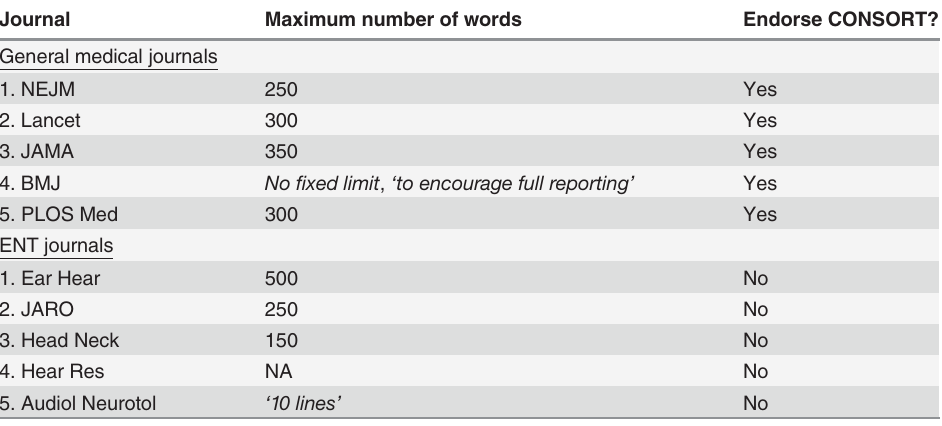
Table 4. Maximum number of words in abstracts and endorsement of CONSORT Statement, per